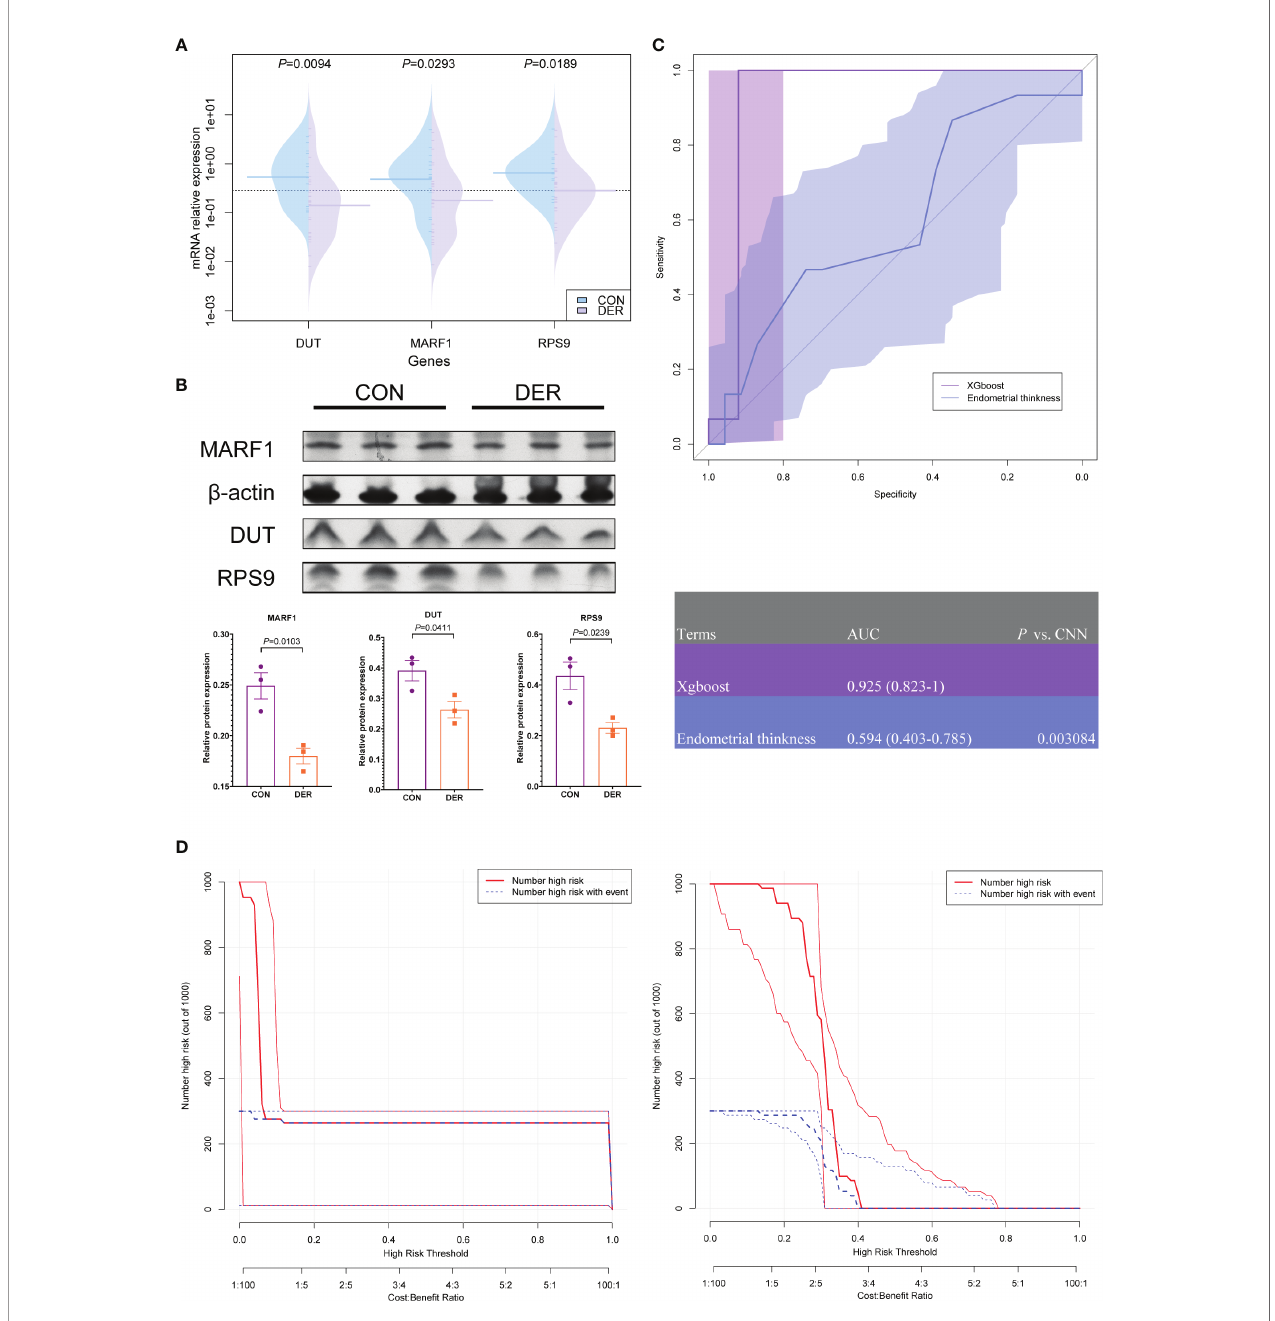
FIGURE 7 | Hub genes and clinical validation and bene fi t analysis of the model. (A) Validation of mRNA expression of hub genes in DER (n=25) and control (n=15) groups. (B) Western blotting result of MARF1, DUT, and RPS9, normalized by b -actin (triplicates in each group). Bar graphs represent the ratio of densities of the respective protein bands and b -actin. Densitometric quanti fi cation graphs of blots are available in Supplementary Figure 2 . (C) ROC of xgboost and ultrasound results of endometrial thickness. The corresponding value of the AUC for each method are presented in the table. (D) Clinical impact curve (CIC) of the xgboost model and endometrial thickness. The red curve (number of high-risk individuals) denotes the number of people classi fi ed as positive (high risk) by the model at each threshold probability; the blue curve (number of high-risk individuals with outcomes) denotes the number of true positives at each threshold